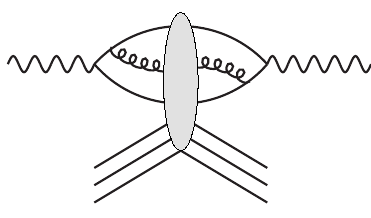
Figure 3: Adding a gluon to the dipole picture of